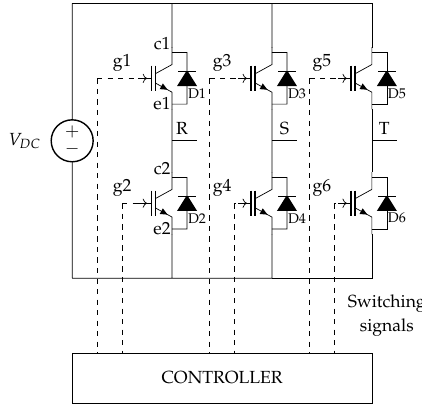
Figure 1. Schematic of a basic three-phase